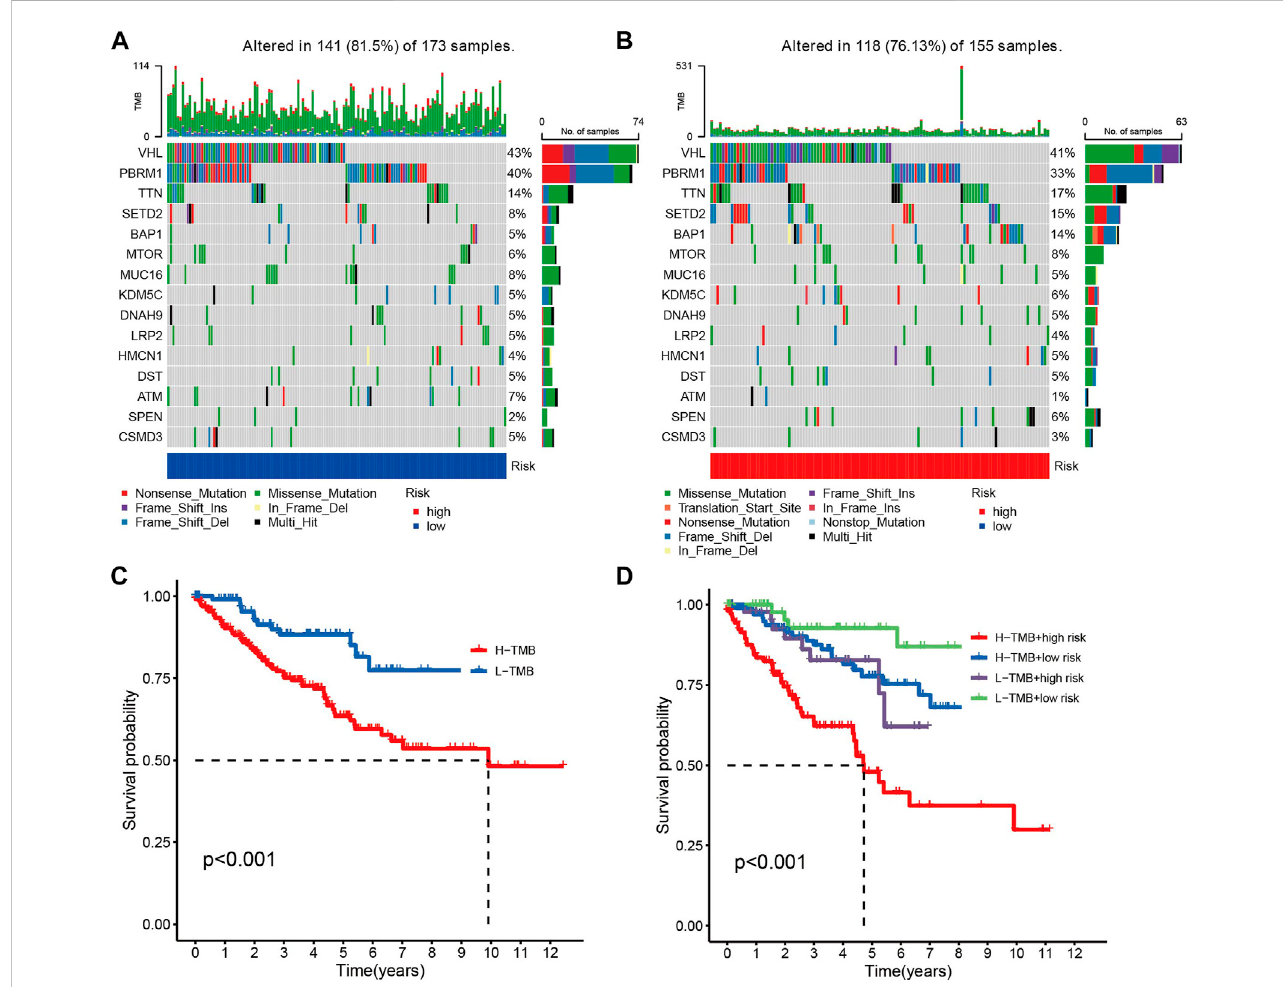
FIGURE 5 (A,B) Comparison chart of gene mutation frequencies. (C) Relationship between tumor mutation load and survival (red means high mutation rate, blue represents low mutation rate). (D) Relationship between TMB and risk score and